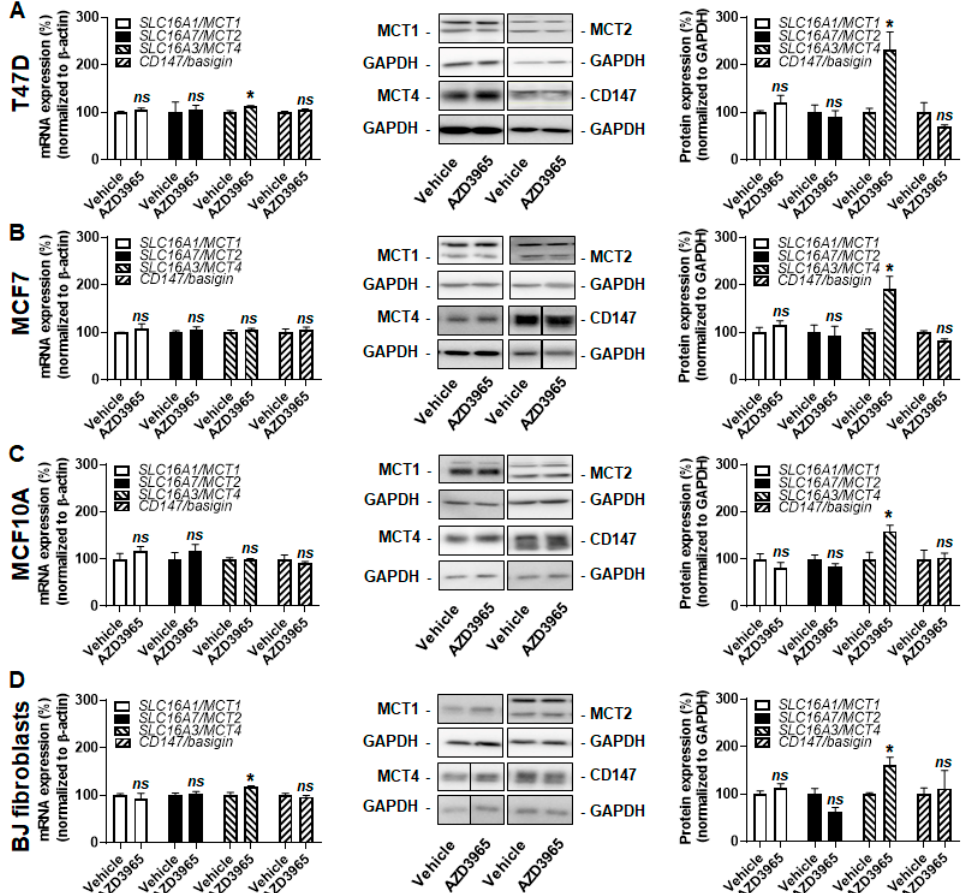
Figure 5. Proliferative breast-associated cells upregulate MCT4 expression upon MCT1 inhibition by AZD3965. ( A – D ) Cells were assayed in medium containing 25 mmol/L glucose with 10 mmol/L GlutaMAX, 10% FBS and without added lactate. ( A ) mRNA (left panel) and protein (middle and right panels) expression of MCT1, MCT2, MCT4 and CD147/basigin in T47D cells treated for 24 h ± 10 µM AZD3965 ( n = 3–6 for RT-qPCR, n = 3 for WB). ( B ) As in A, but using MCF7 cells ( n = 3–6 for RT-qPCR, n = 6 for WB). ( C ) As in A, but using MCF10A cells ( n = 3–6 for RT-qPCR, n = 3–9 for WB). ( D ) As in A, but using BJ fibroblasts ( n = 3–6 for RT-qPCR, n = 3–6 for WB). All data are shown as means ± SEM. * p < 0.05, ns p > 0.05 compared to vehicle; by Student’s t test ( A – D ).